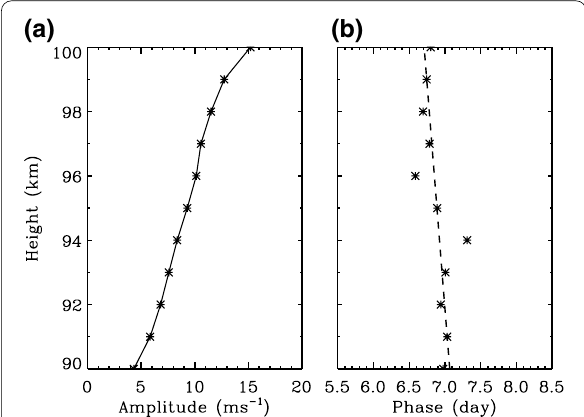
oscillation is the strongest at this height. Morlet wavelet function which consists of a plane wave modulated by a Gaussian envelope is chosen as mother wavelet. Wavelet analysis decomposes a time series into a two-dimensional time–frequency domain, thus it can provide not only the